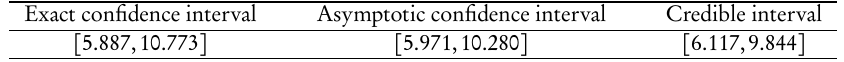
95% intervals of α based on the annual wage